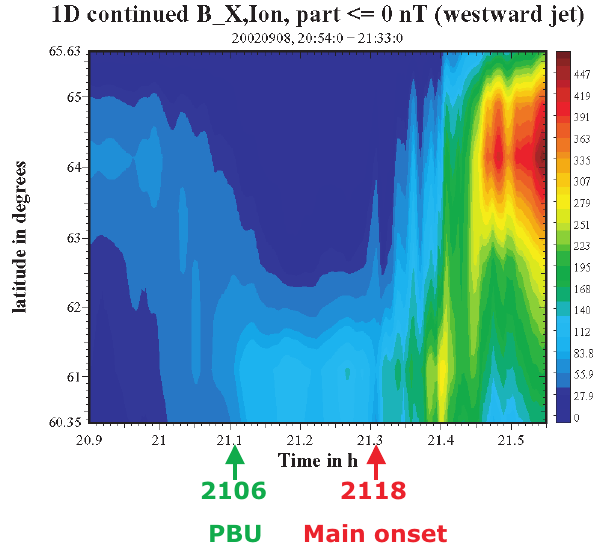
Fig. 16. The time-latitude distribution of the westward equivalent ionospheric currents as deduced from the MIRACLE magnetome- ter data recorded during a substorm on 8 September 2002 (From Sergeev et al., 2005).